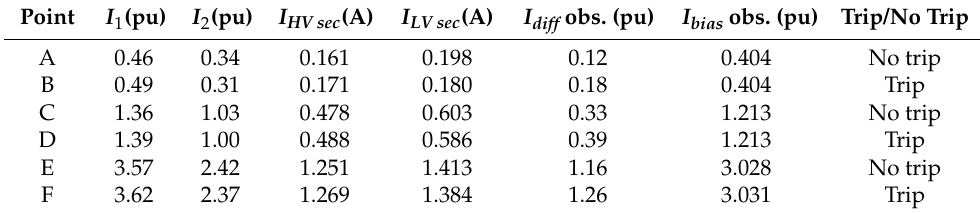
Table 9. Test results of bias characteristics for points selected in Figure 11a.